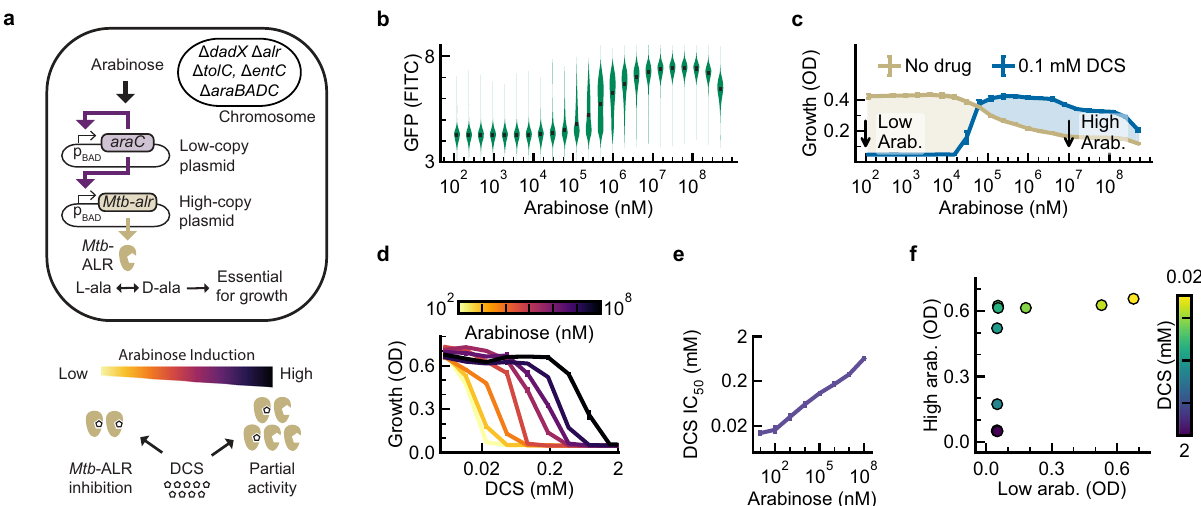
Fig. 1 A TESEC strain for Mtb Alr shows differential sensitivity to targeted inhibitors. a The TESEC host carries deletions of native Alr enzymes, the TolC ef fl ux system, and genes participating in the native arabinose response. Two plasmids carry an arabinose-inducible, feedback-controlled expression circuit for Mtb Alr that produces a smoothed, log-linear induction response 28 . b A violin plot of fl ow cytometry data of Mtb Alr tagged with GFP. Expression was unimodal and log-linear for arabinose concentrations from 10 5 to 10 7 nM. c The effect of arabinose on TESEC growth in the presence or absence of 100 μ M DCS. Shaded areas indicate the differential growth response to DCS. The indicated high and low arabinose concentrations were selected for use for screening. Data are presented as the mean and CI 95 of 8 biological replicates. d TESEC Mtb Alr dose-response to DCS for a range of arabinose concentrations. Error bars are CI 95 of 4 biological replicates. e The half-maximal effective dose of DCS varied by more than 50-fold as the arabinose induction level was varied. Error bars are CI 95 of best- fi t parameter estimates. f A mock differential screen of high- and low- induction TESEC for a range of DCS concentrations. Simulated hits appear as off-diagonal points where growth inhibition is observed for only the low-induction strain. Source data are provided as a Source Data fi